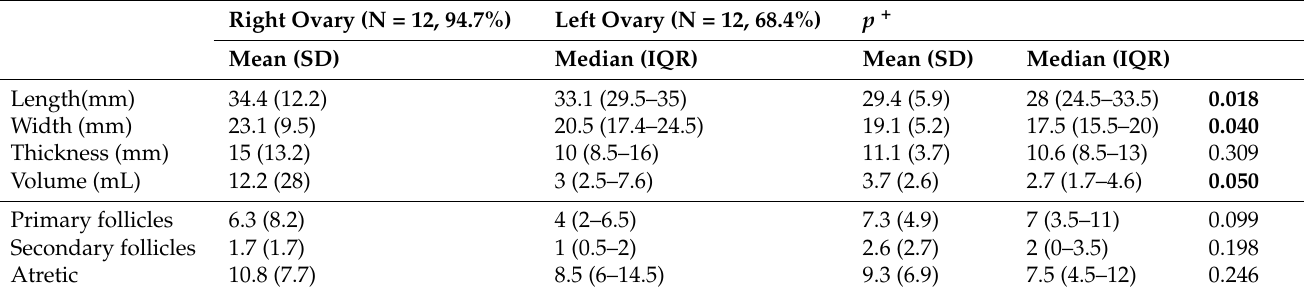
Table 2. Measurements for each